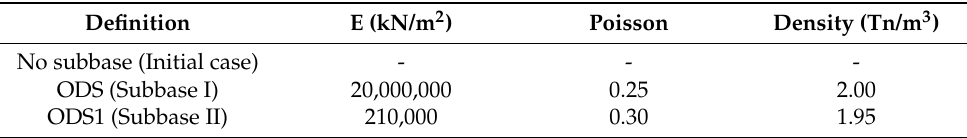
Table 6. Material properties for the analysed